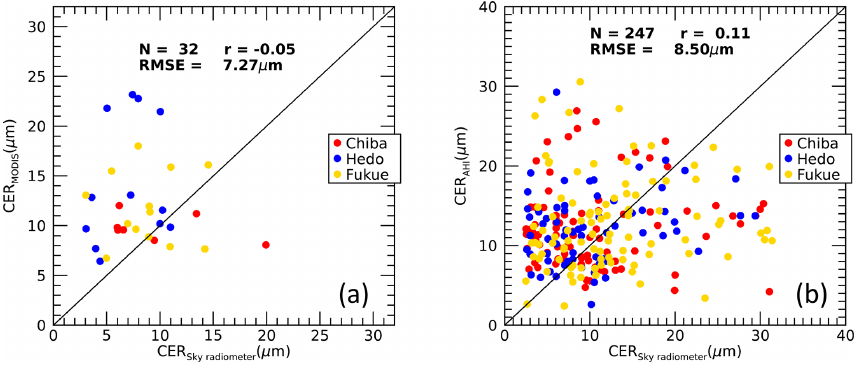
Figure 8. Same as Fig. 7 but for a comparison of cloud particle effective radii